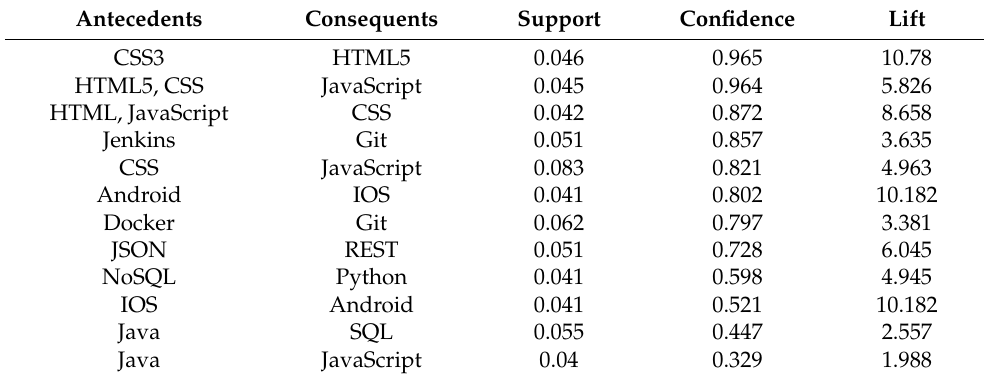
Table 1. Association rules